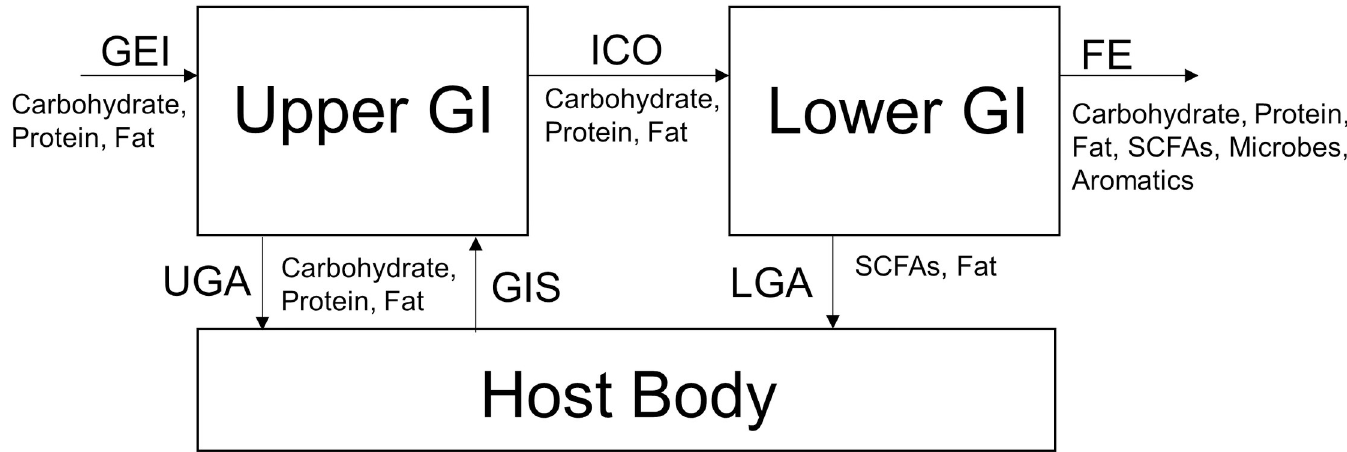
Fig 1. The overall material flows of our model. The abbreviations are gross energy intake (GEI), upper GI absorption (UGA), gastrointestinal secretions (GIS), ileocecal output (ICO), lower GI absorption (LGA), and fecal energy (FE). While not explicitly modeled, the gastrointestinal host acts as the source for GIS and sink for UGA and